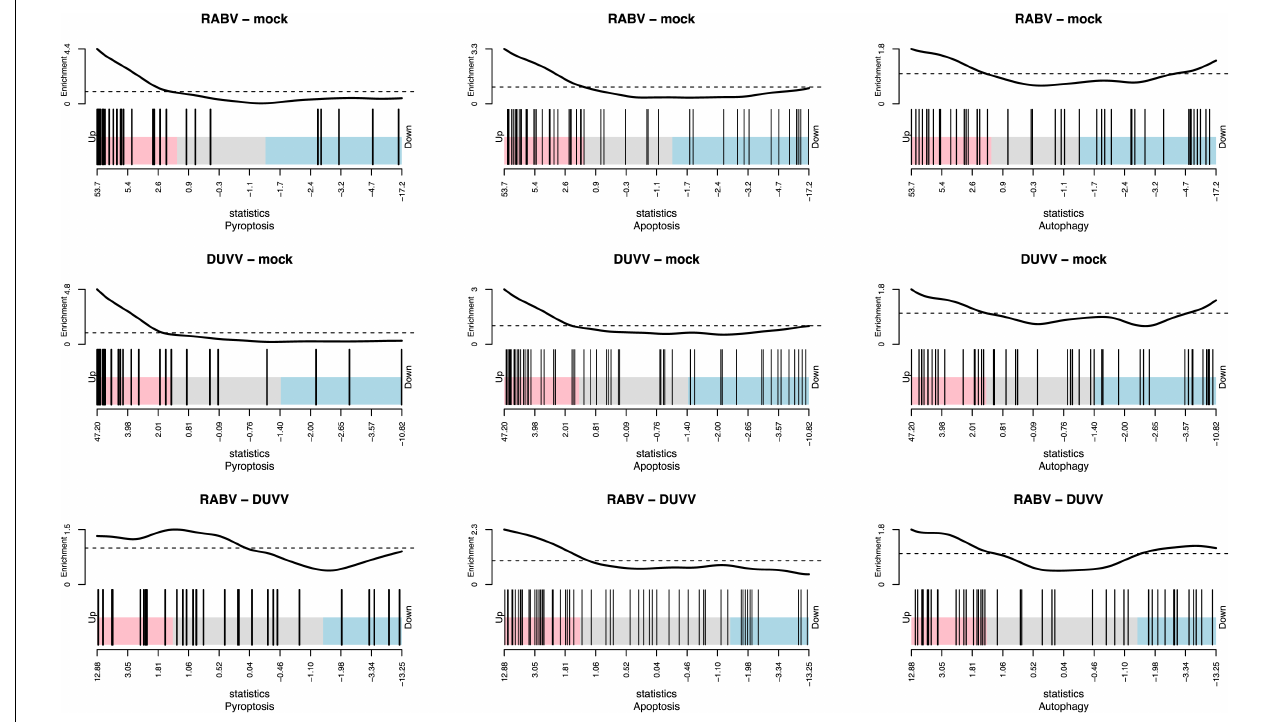
FIGURE 4 | Enrichment index for pyroptosis, apoptosis, and autophagy after DUVV-NL07 and RABV-PV infection of BALB/c